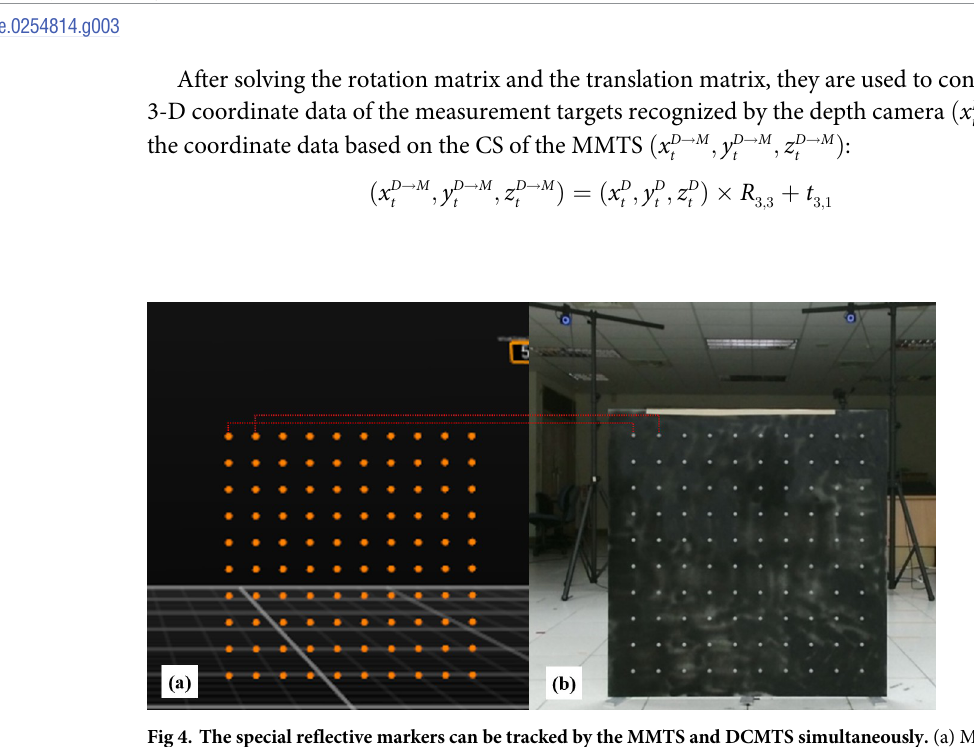
Fig 4. The special reflective markers can be tracked by the MMTS and DCMTS simultaneously. (a) MMTS view: the screenshot of the Motive software (OptiTrack Motion Capture System, NaturalPoint, Inc., USA) showed that one hundred markers were identified by the MMTS; (b) DCMTS view: the photo taken by a depth camera (the color space data (pixel, (x, y)) of each reflective marker on this picture was mapped onto camera space data (3-D space, (x, y, z))).